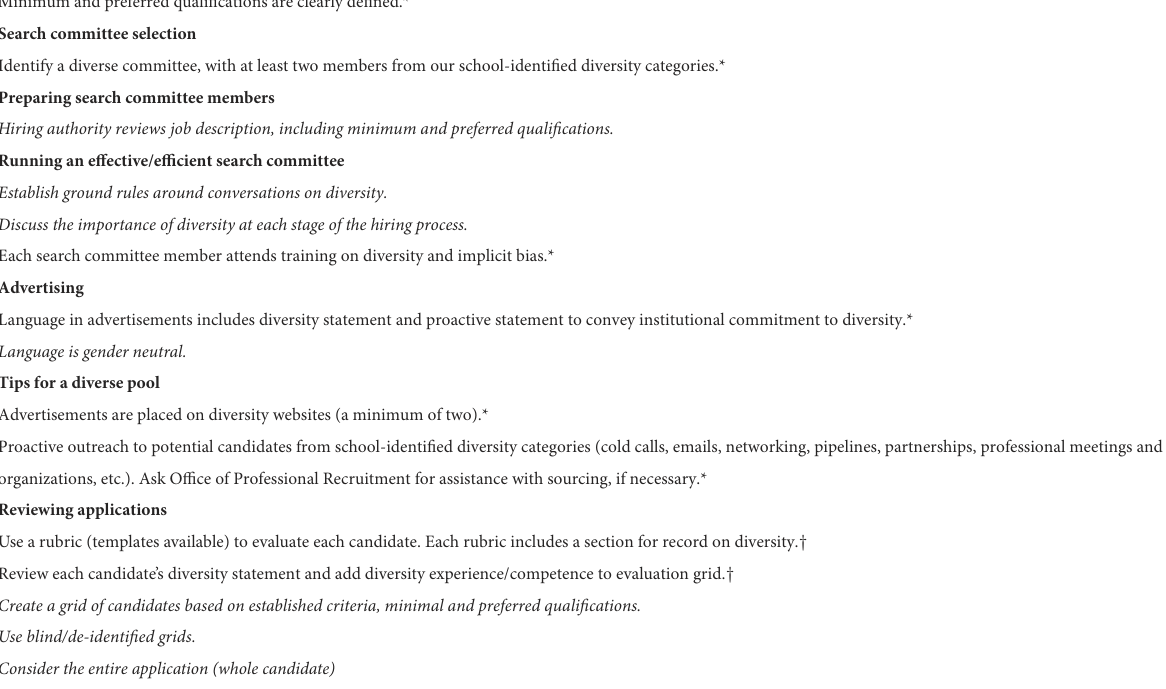
TABLE 1 Diversity checklist guidelines established to identify best practices and promote diversity in the search process.